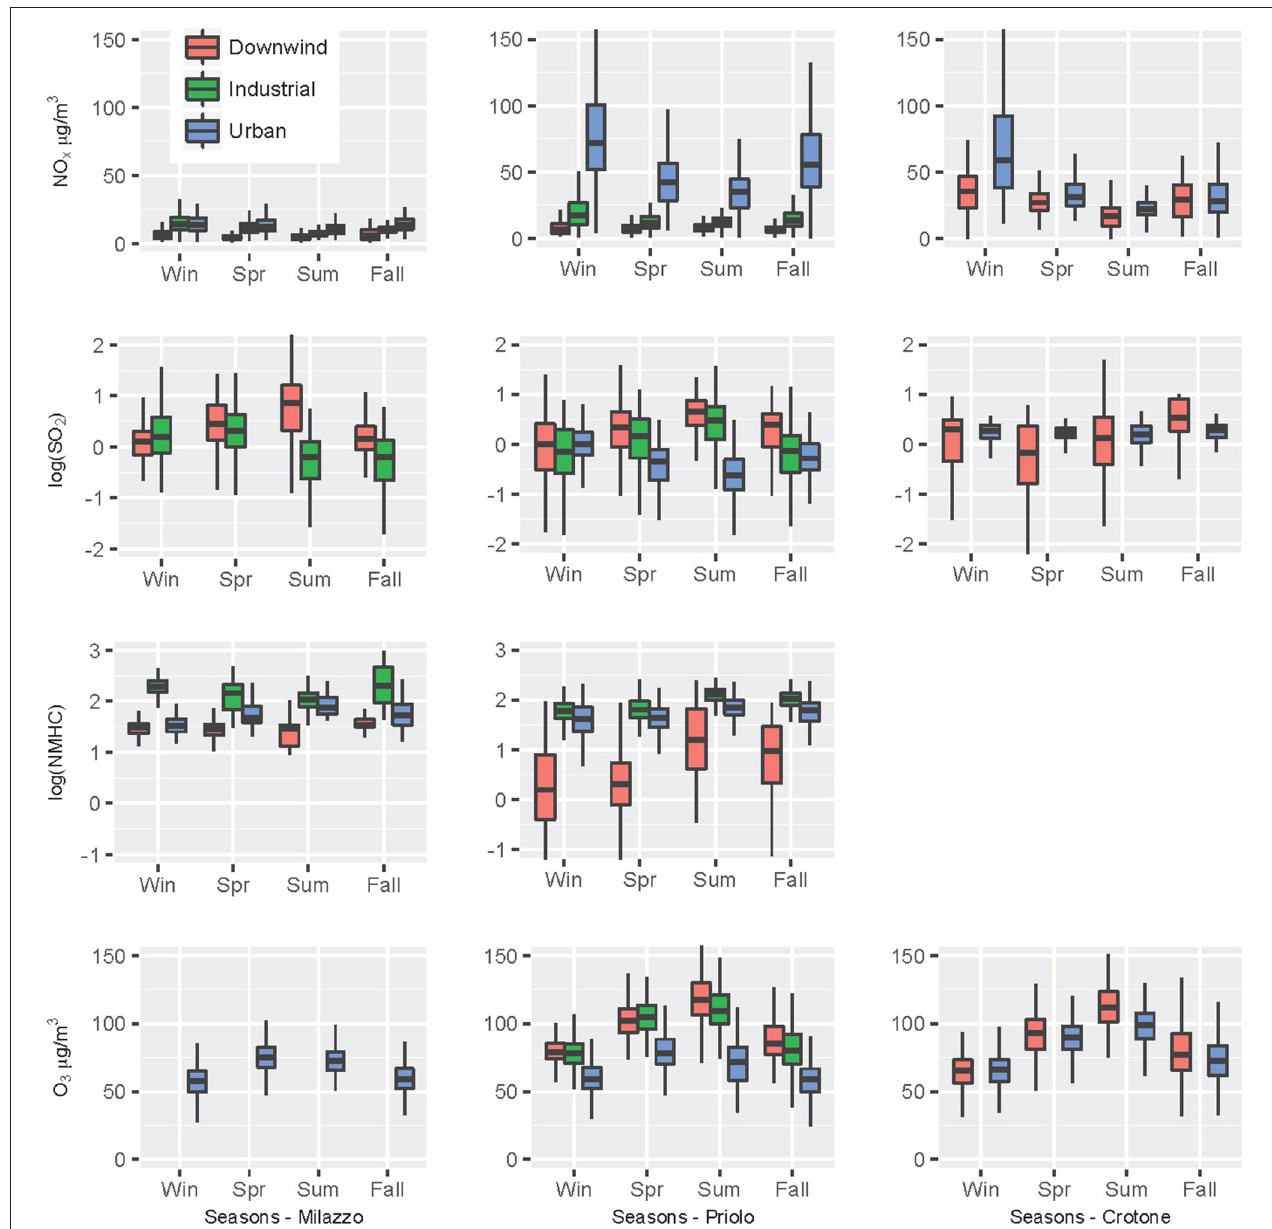
FIGURE 5 | Box plot of NOx, SO 2 , and NMHC daily means and O 3 8-h means grouped by AERCA and season. Each colored column corresponds to a different AERCA site, according to Table 1 .